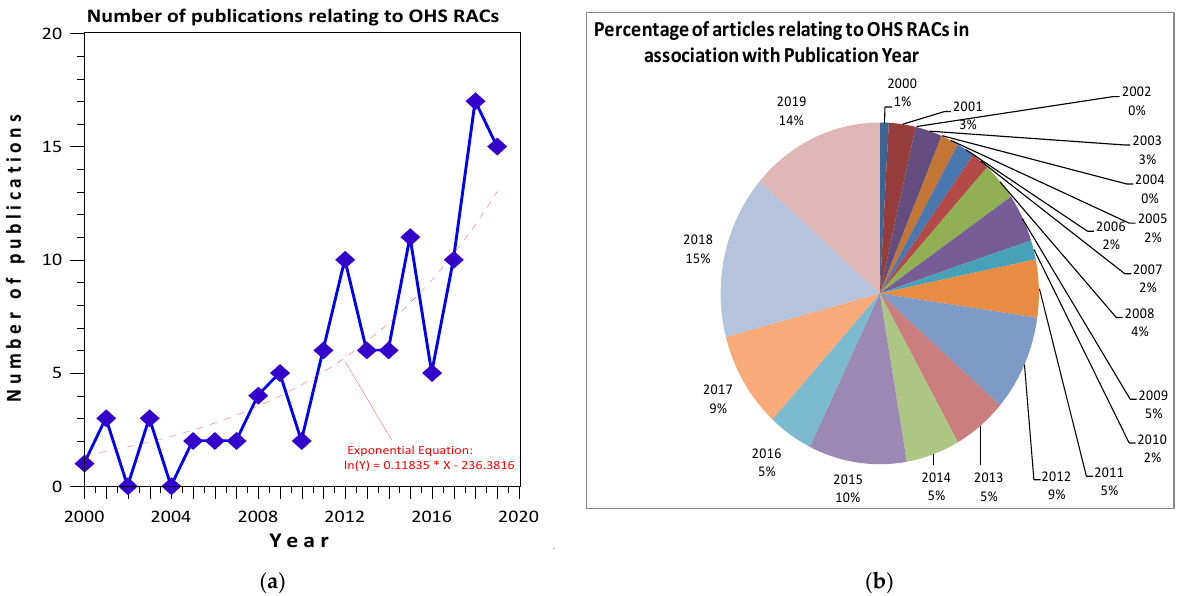
Figure 9. ( a ) The graph shows the alteration of the number of publications relating to OHS RACs throughout the period of years 2000 – 2019. ( b ) Distribution of the articles concerning OHS RACs according to the year of publication.